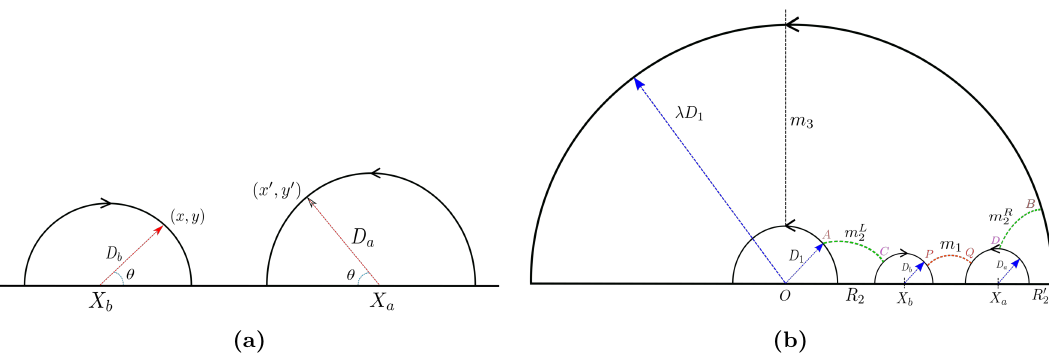
Figure 4. (a) The general orientation reversing isometry that maps the point ( x, y ) on g b circle to a point ( x 0 , y 0 ) on g a circle. (b) The covering space of the multiboundary wormhole. The notations are explained in the main